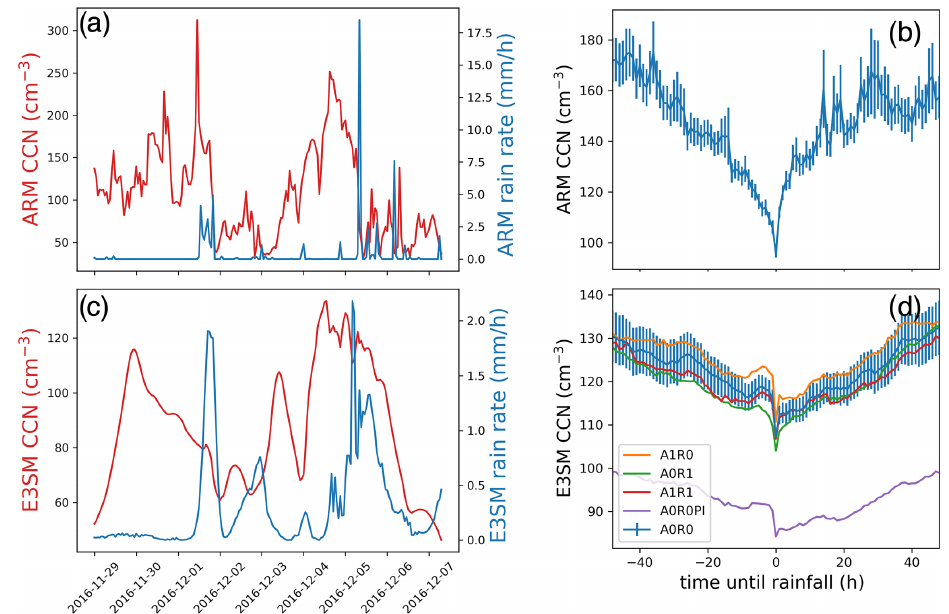
Figure 6. (a) CCN concentration and rain rate from ARM hourly measurements. (b) CCN concentration measured at ARM averaged over the period 21 June 2016–29 August 2020 grouped by the amount of time until a rain event occurs with a threshold above 0.05mmh − 1 . (c) The same as (a) except using simulations from the E3SM model A0R0 model run. (d) The same as (b) except using simulations from each E3SM experiment. Note that the range of CCN ( y axes) values is larger in ARM compared to